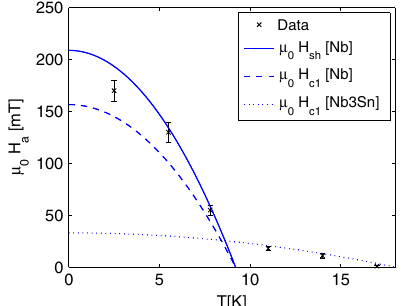
FIG. 15. Measured field of first flux entry of a Nb 3 Sn coated Nb ellipsoid. The lines are predictions for the superheating field H sh of Nb and the lower critical field H of Nb 3 Sn and Nb taking into c 1 account the demagnetization factor of this geometry N ¼ 0 . 13